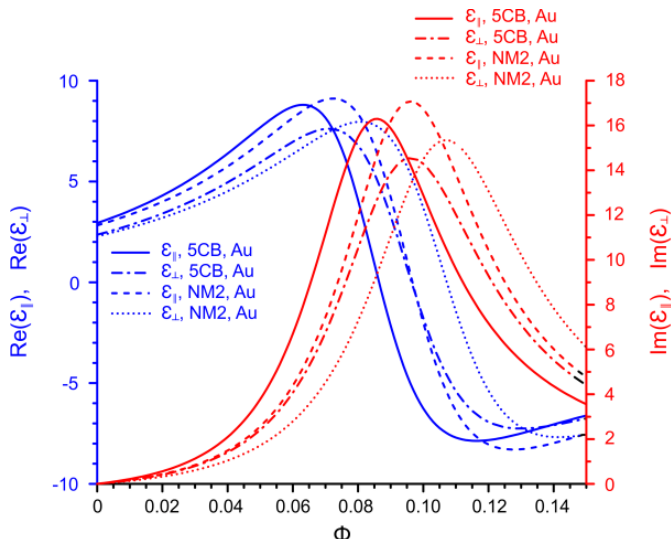
Figure 6. The dependence of Re ( ε (cid:107) ) , Im ( ε (cid:107) ) , Re ( ε ⊥ ) and Im ( ε ⊥ ) on the volume fraction of AuNPs φ for the two different nematic hosts 5 CB and NM 2 a fixed wavelength of light λ = 589